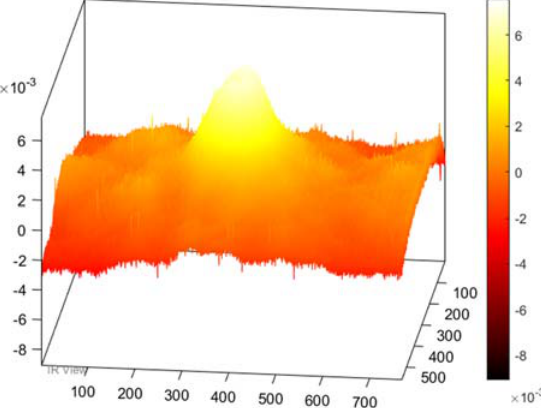
Figure 10. 3D of the sample corresponding to PPT.